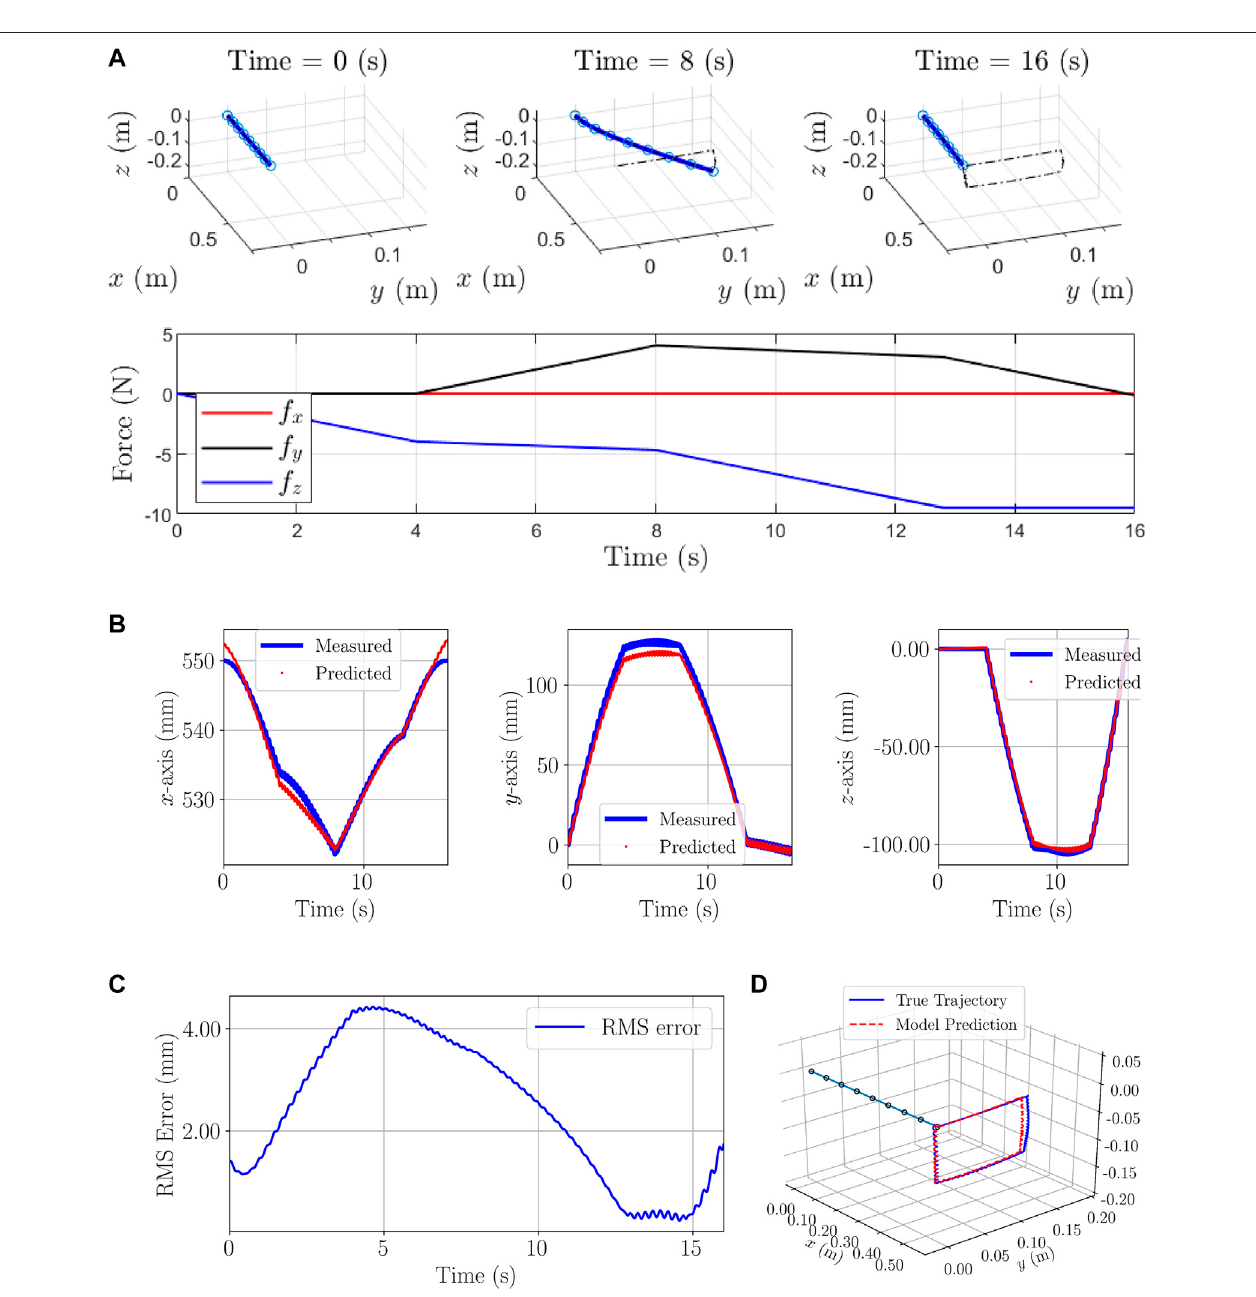
FIGURE 5 | Second simulation example: (A) : Initial, Time-evolved con fi gurations and forces on the last node. (B) : Tip positions: calculated from the analytical dynamic model and predicted by the proposed RNN-based model. (C) RMS error considering all the axes. (D) Predicted and measured trajectories.